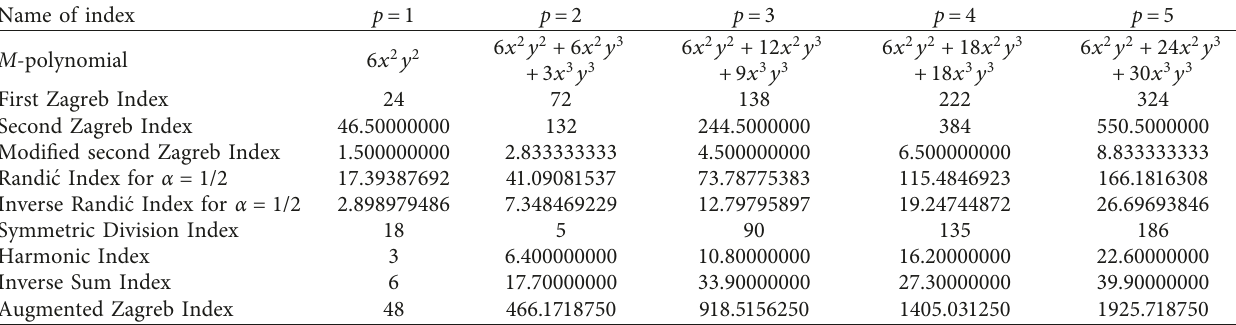
Table 1: Topological indices of triangular benzenoid for different values of p